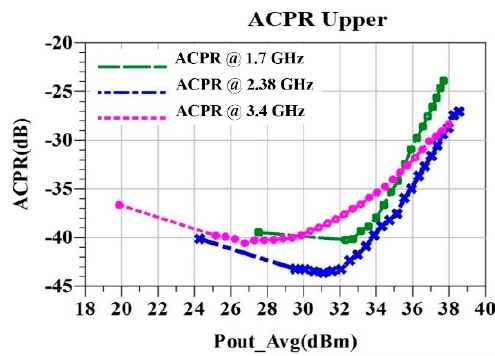
Figure 21. Adjacent Channel Power Ratio (ACPR) measurements for the fabricated Doherty Amplifier. The amplifier is driven by a 16 QAM WCDMA signal with a 40 MHz bandwidth and a Peak to Average Power Ratio (PAPR) of 6.5dB.